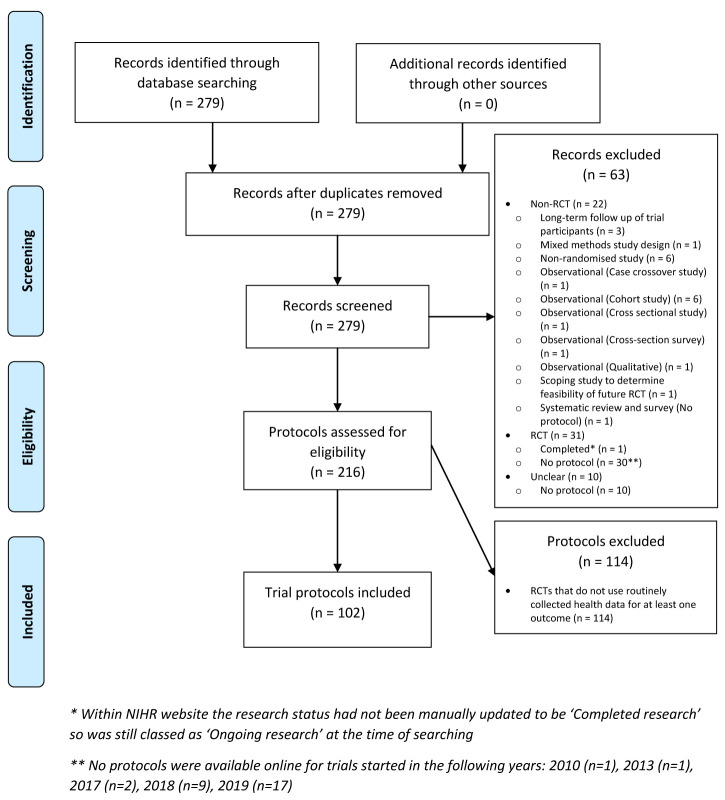
PRISMA flow diagram.